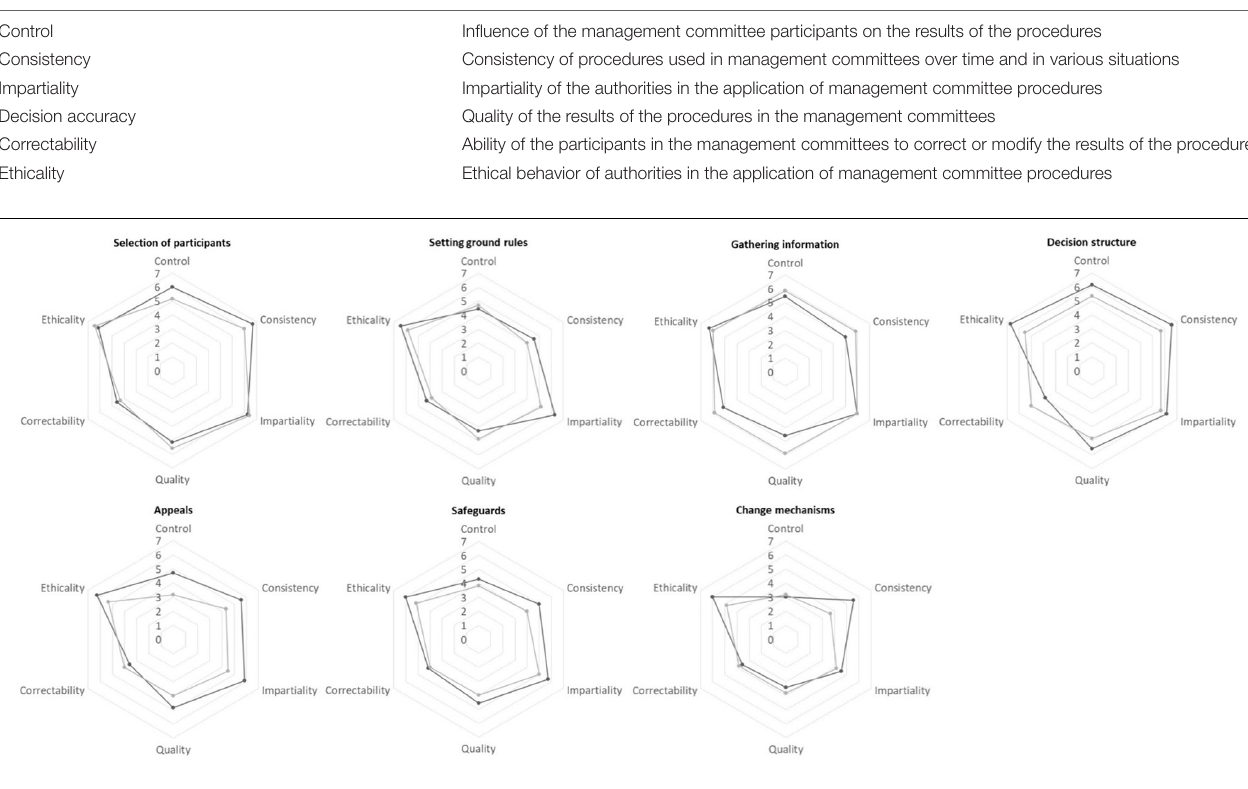
FIGURE 2 | Components for the evaluation of seven components of procedural justice in the Bay of Ancud Management Committee (black line) and the Gulf of Arauco Management Committee (gray